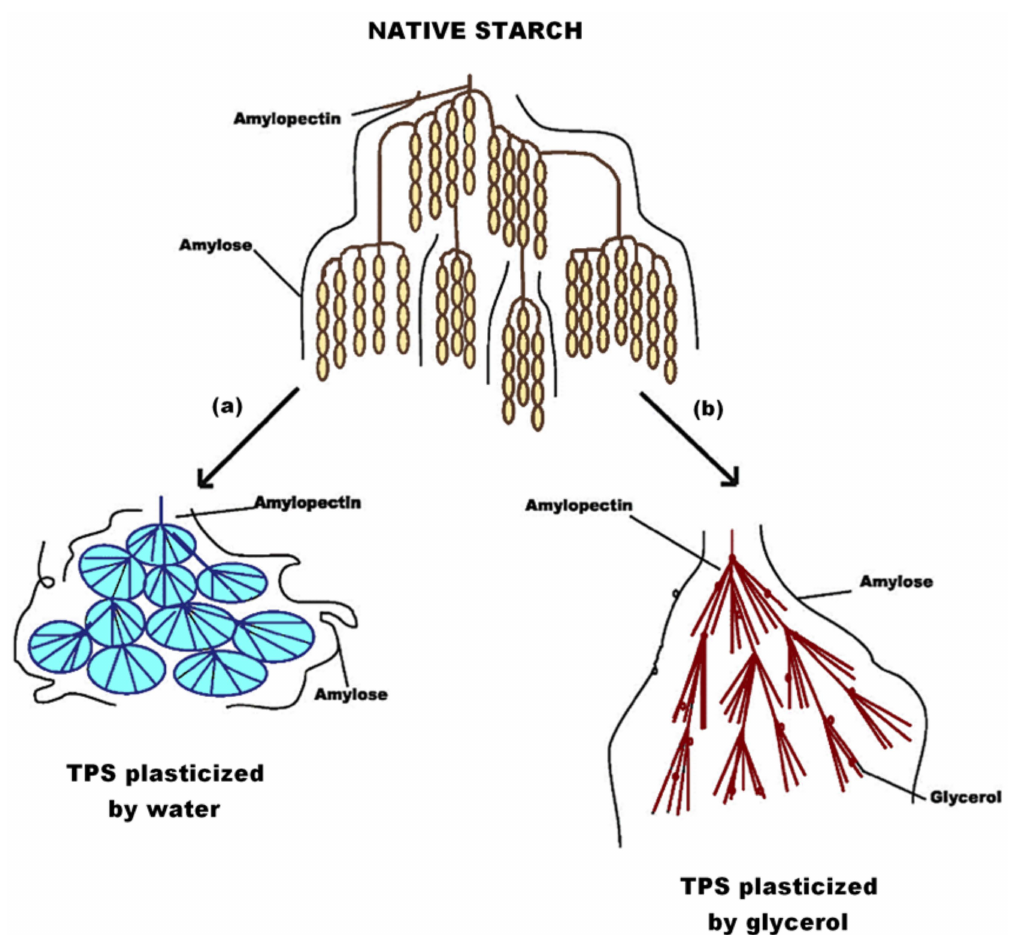
Figure 5. Microstructural change in native starch processing to TPS plasticized with ( a ) water and ( b ) glycerol. Reproduced with permission from J. Food Process Eng. , 40 , Khan et al., Thermoplastic Starch: A Possible Biodegradable Food Packaging Material—A Review, 2017